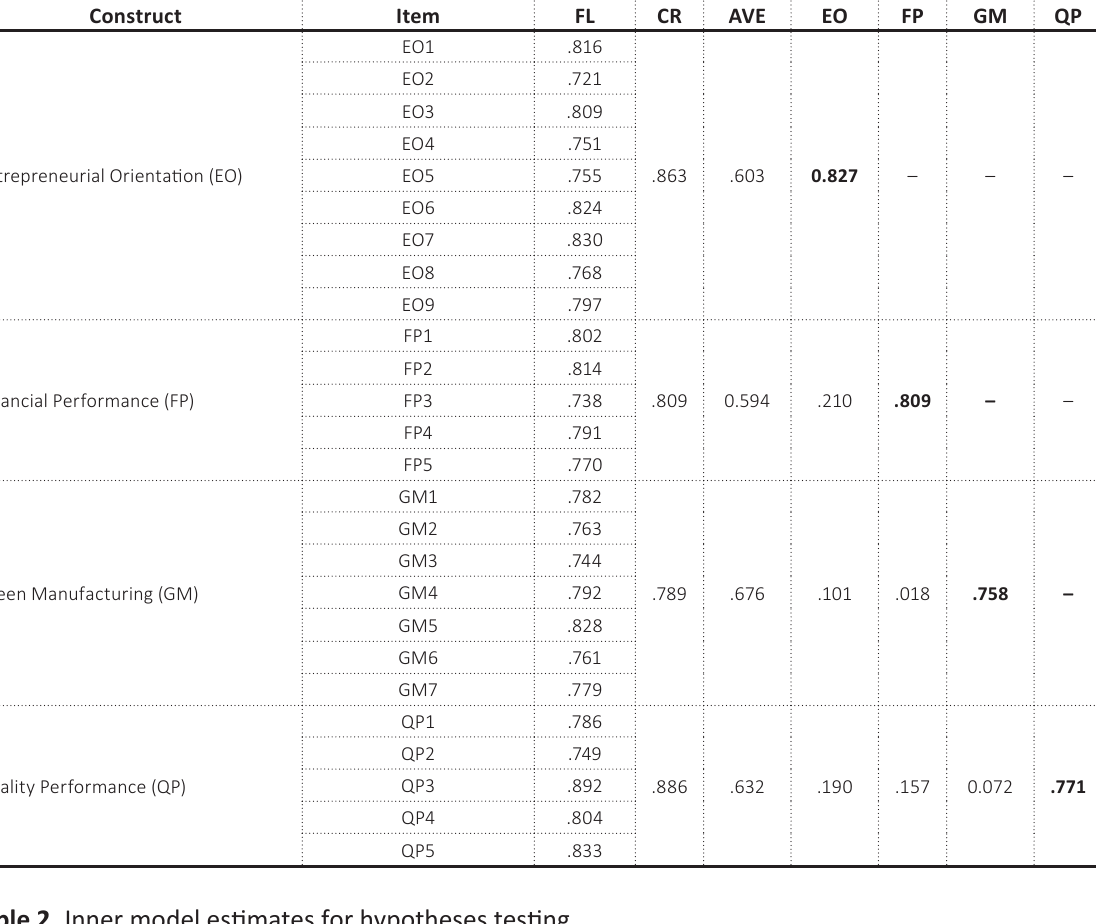
Table 1. Outer model estimates